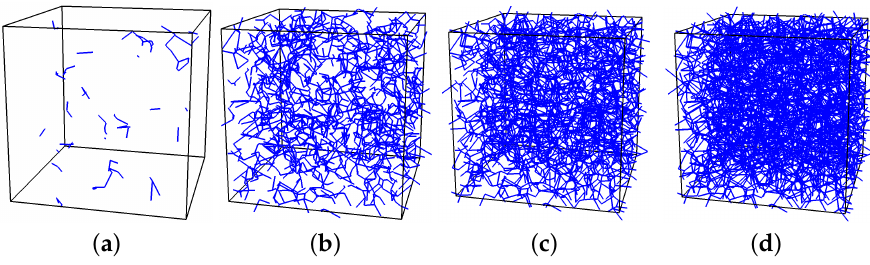
Figure 10. Constrained swelling analysis: spatial distribution of pipes filled with wetting fluid at the four stages of capillary suction marked in Figure 7 to Figure 9. The capillary suction values of the four stages are ( a ) 6.61 × 10 3 , ( b ) 2.37 × 10 3 , ( c ) 1.43 × 10 3 and ( d ) 0.36 × 10 3 Pa.